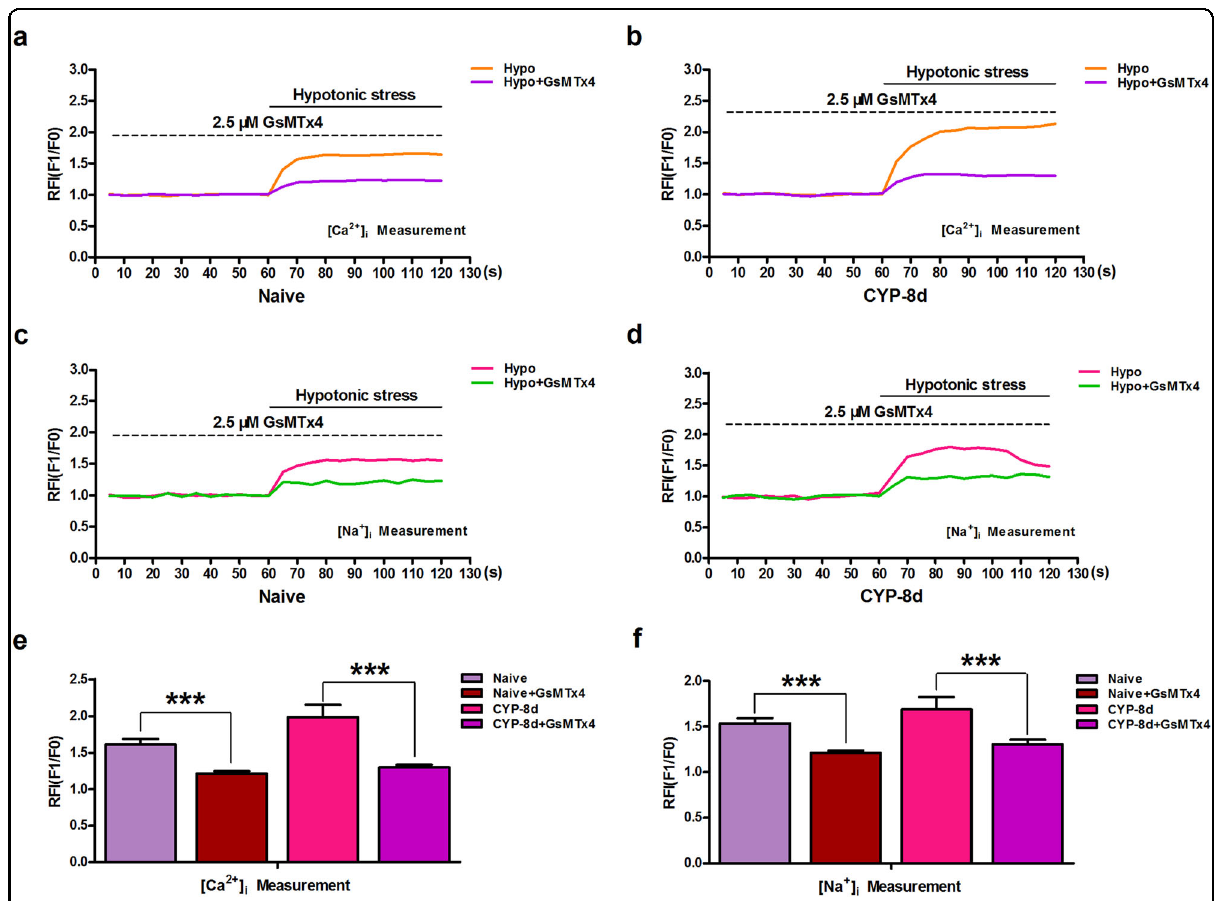
Fig. 4 Piezo1 channel activation induced by hypotonic stress triggered robust Ca 2 + and Na + in fl uxes into bladder ICC-LCs during CYP- induced chronic cystitis. a – d The effects of hypotonic stress and GsMTx4 on [Ca 2 + ] i and [Na + ] i are represented by the relative fl uorescence intensities (RFI, F1/F0), which are illustrated as continuous curves. Upon hypotonic stress application, [Ca 2 + ] i and [Na + ] i in bladder ICC-LCs from naive and CYP-8d rats were signi fi cantly elevated. Although 2.5 μ M GsMTx4 signi fi cantly reduced the effects of hypotonic stress on both [Ca 2 + ] i and [Na + ] i . e , f The reduction in [Ca 2 + ] i and [Na + ] i induced by GsMTx4 was considered to be accounted for by the Ca 2 + and Na + in fl ux provoked by Piezo1 channel activation. Therefore, compared with bladder ICC-LCs from naive rats, Ca 2 + and Na + in fl ux triggered by Piezo1 channel activation was signi fi cantly enhanced in bladder ICC-LCs from CYP-8d rats, and the enhancement in Ca 2 + in fl ux was more prominent than that in Na + in fl ux (the data represent the mean ± S.D., n = 10; *** P < 0.001, versus GsMTx4